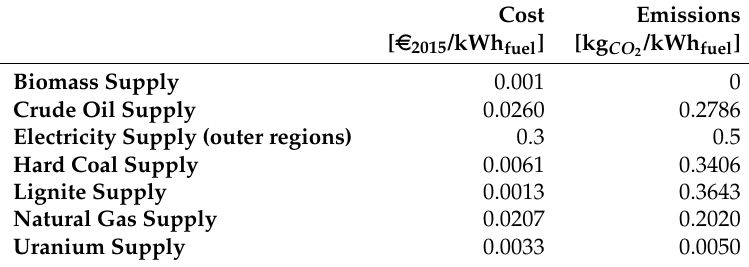
Table A7. Cost and emission data for fuels which are used as model input data for all